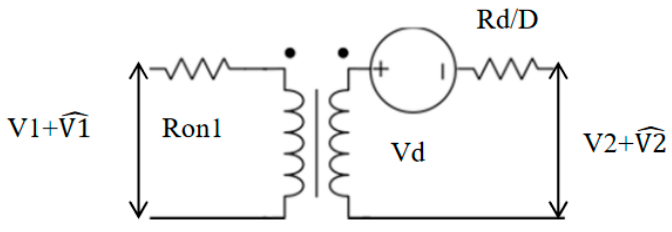
4 of 15 Figure 3. Equivalent switch network, where {1} is (cid:2914)(cid:3553)(cid:2906)(cid:2869) (cid:2914)∗(cid:2914) (cid:4594) and {2} is (cid:2893)(cid:2870)(cid:2914)(cid:3553) (cid:2914)∗(cid:2914) (cid:4594) . 4. Circuit Averaging for a Non-Ideal SEPIC Figure 4 shows the non-ideal SEPIC with V 0 = Vc2. Figure 4. Switches separated. < V1 > = d(cid:3435)Ron1 ∗ (iL1 + iL2)(cid:3439) + d′((Vc1 + Vc2) + Vd + Rd(iL1 + iL2))